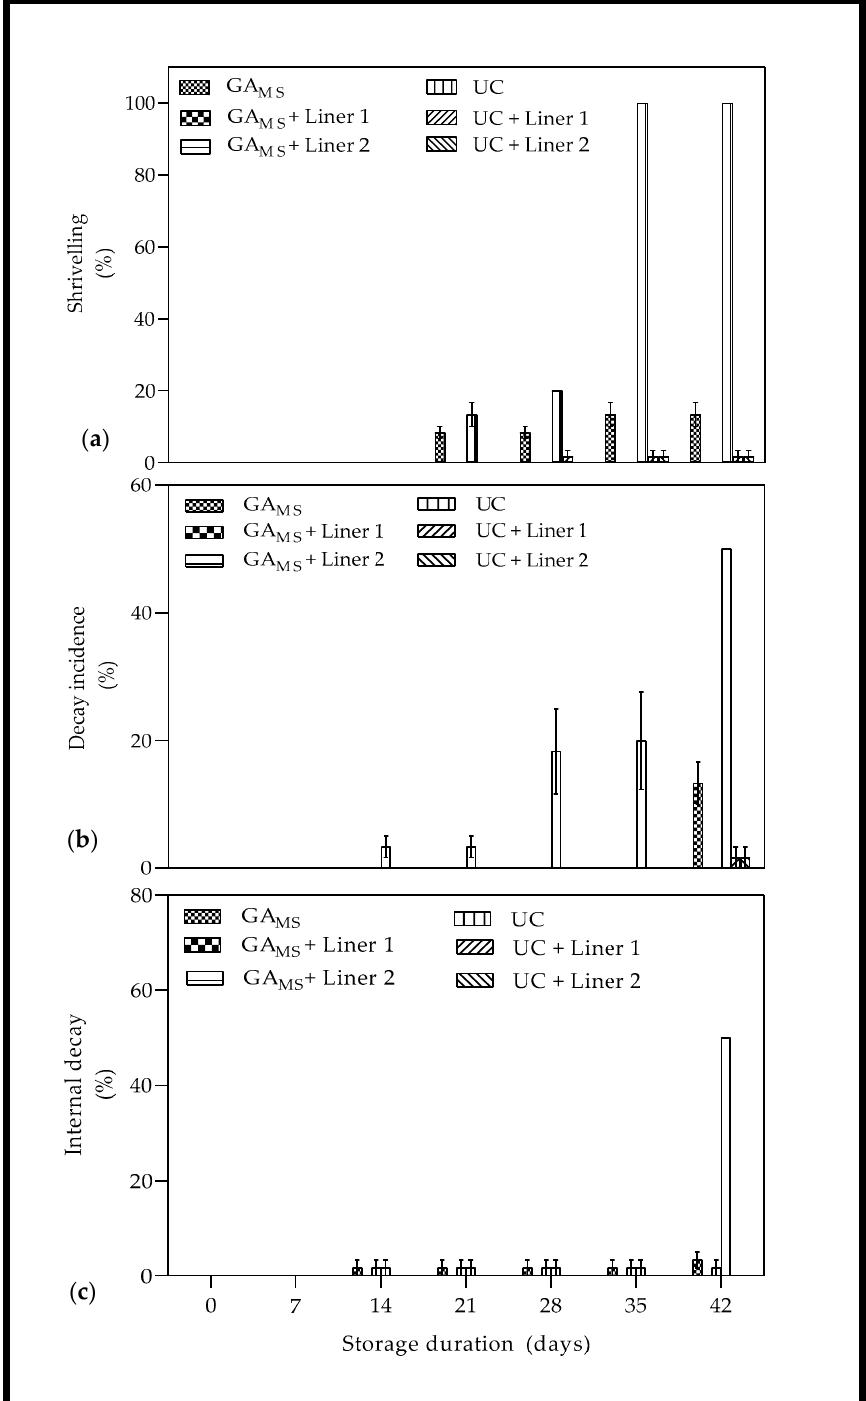
Figure 4. Incidence of ( a ) Shriveling, ( b ) external decay and ( c ) internal decay in ‘Wonderful’ pomegranate coated and packaged in different polyliners and stored (5 ± 1 °C, 95 ± 2% RH) for 42 d. GA MS —gum Arabic (0.5% w / v ) and maize starch (0.5% w / v ); Liner 1—Xtend ® liner (20 µmm perforations); Liner 2—perforated liner (4 mm perforations); UC—uncoated fruit.